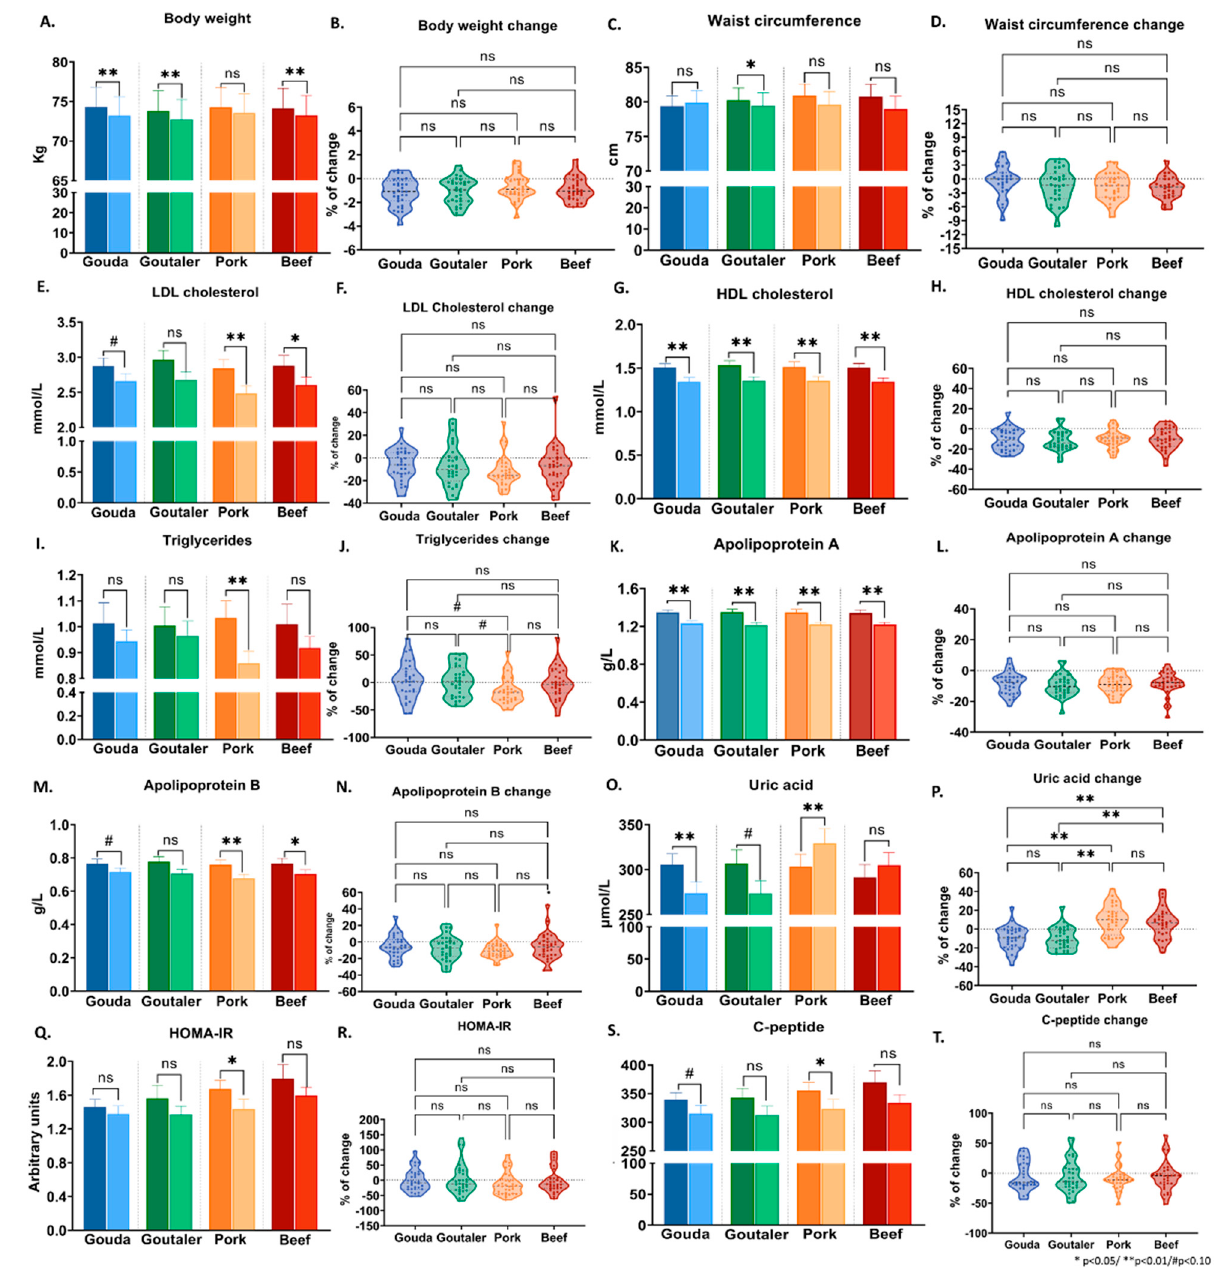
Figure 1. Effects of the four test diets (Gouda- and Goutaler-type cheeses, pork, and beef) on clinical markers. Before and after values for each test diet were analyzed with RM-ANOVA, while differences between test diets were investigated with mixed models for repeated measures. The figure represents the results for body weight ( A , B ), waist circumference ( C , D ), LDL cholesterol ( E , F ), HDL cholesterol ( G , H ), triglycerides ( I , J ), apolipoproteins A ( K , L ) and B ( M , N ), uric acid ( O , P ), HOMA-IR ( Q , R ), and C-peptide ( S , T ). Pre- and post-comparisons were analyzed using RM-ANOVA (for individual test diets) with body weight change and gender as covariates and period of diet as a between-subject factor ( A , C , E , G , I , K , M , O , Q , S ). Differences in the percent of change between diets were analyzed using mixed models for repeated measures with body weight change, period, and gender as covari- ates. Bonferroni’s post hoc test was used for pairwise comparisons ( B , D , F , H , J , L , N , P , R , T ). Symbols: n.s. = non-significant; # p < 0.10; * p < 0.05; ** p <